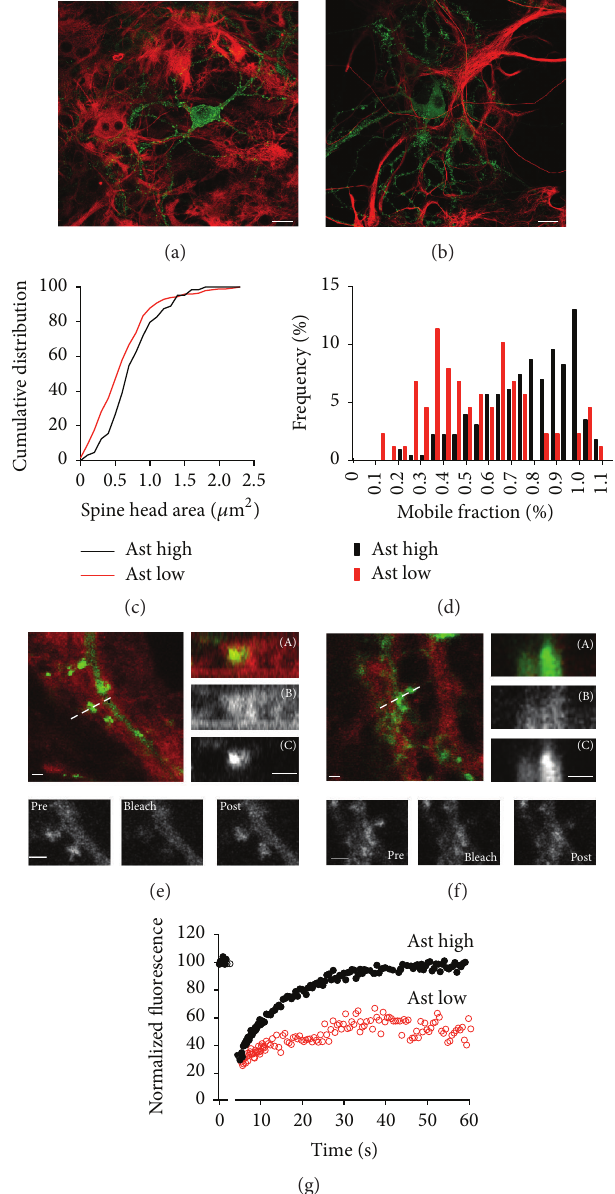
Figure 2: Astrocyte contact regulates actin mobile fraction. (a-b) The pictures show two neurons growing over a layer of astrocytes ((a) “Ast high” condition), or in the near-absence/absence of astrocytes ((b) “Ast low” condition). Notice how in the “Ast low” condition a large part of the neuron has no contact with the surrounding astrocytes. Neurons were transfected with GFP-actin (green) and astrocytes were identified by GFAP staining (red). Scale bar: 10 𝜇 m, 21 days in vitro. (c) Cumulative distribution of spine head areas comparing “Ast high” (black) versus “Ast low” (red) ( 𝑛 = 198 spines “Ast high” and 𝑛 = 64 spines “Ast low”) (Kolmogorov-Smirnov test, ns). (d) Frequency distribution of mobile fractions in “Ast low” conditions (red bars) ( 𝑛 = 82 spines). Of interest is that the MF was drastically reduced in the “Ast low” condition, as compared to the “Ast high” condition (Mann-Whitney test, 𝑝 < 0.0001 ). The mobile fraction values distribution of “Ast high” conditions was included for comparison (black bars). (e and f) In vivo confocal images. (e) To evaluate the presence of direct astrocyte contact with the recorded spine, membranes were stained with the lipophilic dye FM4-64 (4 𝜇 M, red). The dendrite shown in (e) “Ast high” condition was lying on top of an astrocytic layer. Longitudinal sections at higher magnification were performed to study spine surroundings (approximately marked as a dashed line), pictures (A) to (C) (overlap, FM4-64 and GFP-actin, resp.). Scale bar: 1 𝜇 m. Bottom: detailed pictures of selected frames obtained from the FRAP experiment, prebleach, bleach, and postbleach. Scale bar: 1 𝜇 m ( 𝑛 = 8 ). (f) Detailed picture of a dendrite growing in “Ast low” conditions. Scale bar: 1 𝜇 m. Notice how FM4-64 staining was only present along the dendrite, but not surrounding the spine. A section of the optical longitudinal acquisition is shown in pictures (A), (B) and (C). Bottom: selected frames obtained from the FRAP experiment, prebleach, bleach, and postbleach. Scale bar: 1 𝜇 m ( 𝑛 = 5 ). (g) Normalized fluorescence recovery curve of the depicted spines growing in “Ast high” (black dots) and “Ast low” (red dots). Notice that spines growing in “Ast high” conditions are characterized by a recovery close to 80%, while spines growing in “Ast low” conditions present a recovery close to